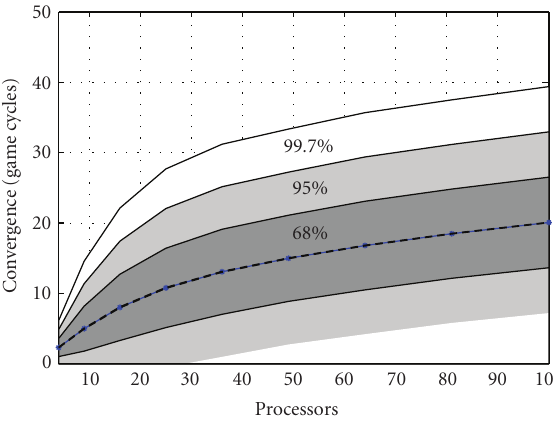
Figure 4: Convergence speed distribution from 4 to 100 processors with w syn = 1 and w temp = 0. The mean and standard deviations are